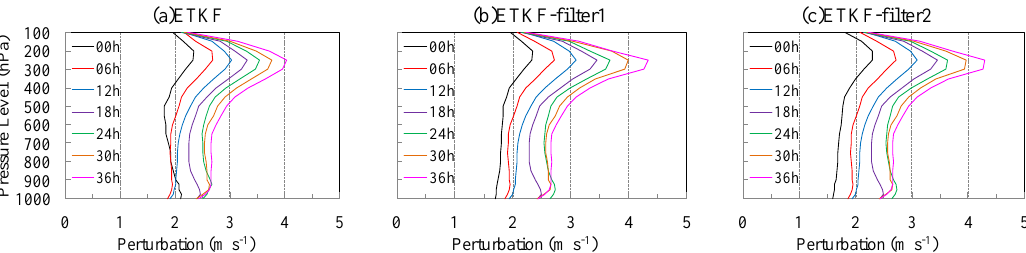
Figure 4. Ten-day averaged absolute value profile of zonal wind perturbation at different forecast times: ( a ) ETKF, ( b ) ETKF-filter1, and ( c ) ETKF-filter2.